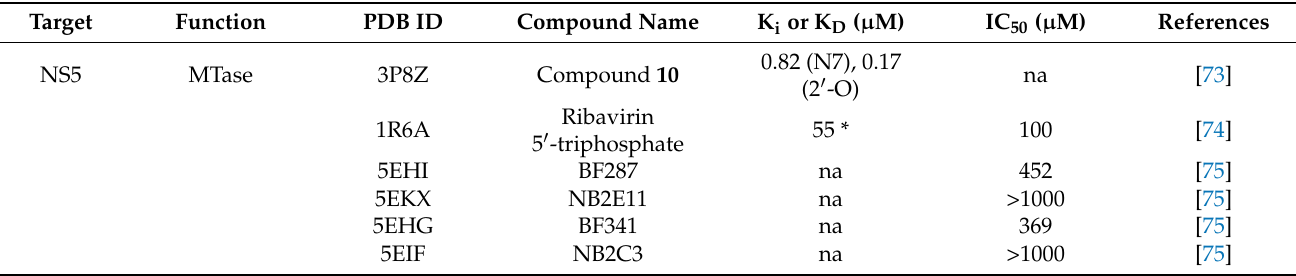
Table 1. Small Molecule Inhibitors against dengue NS3 and